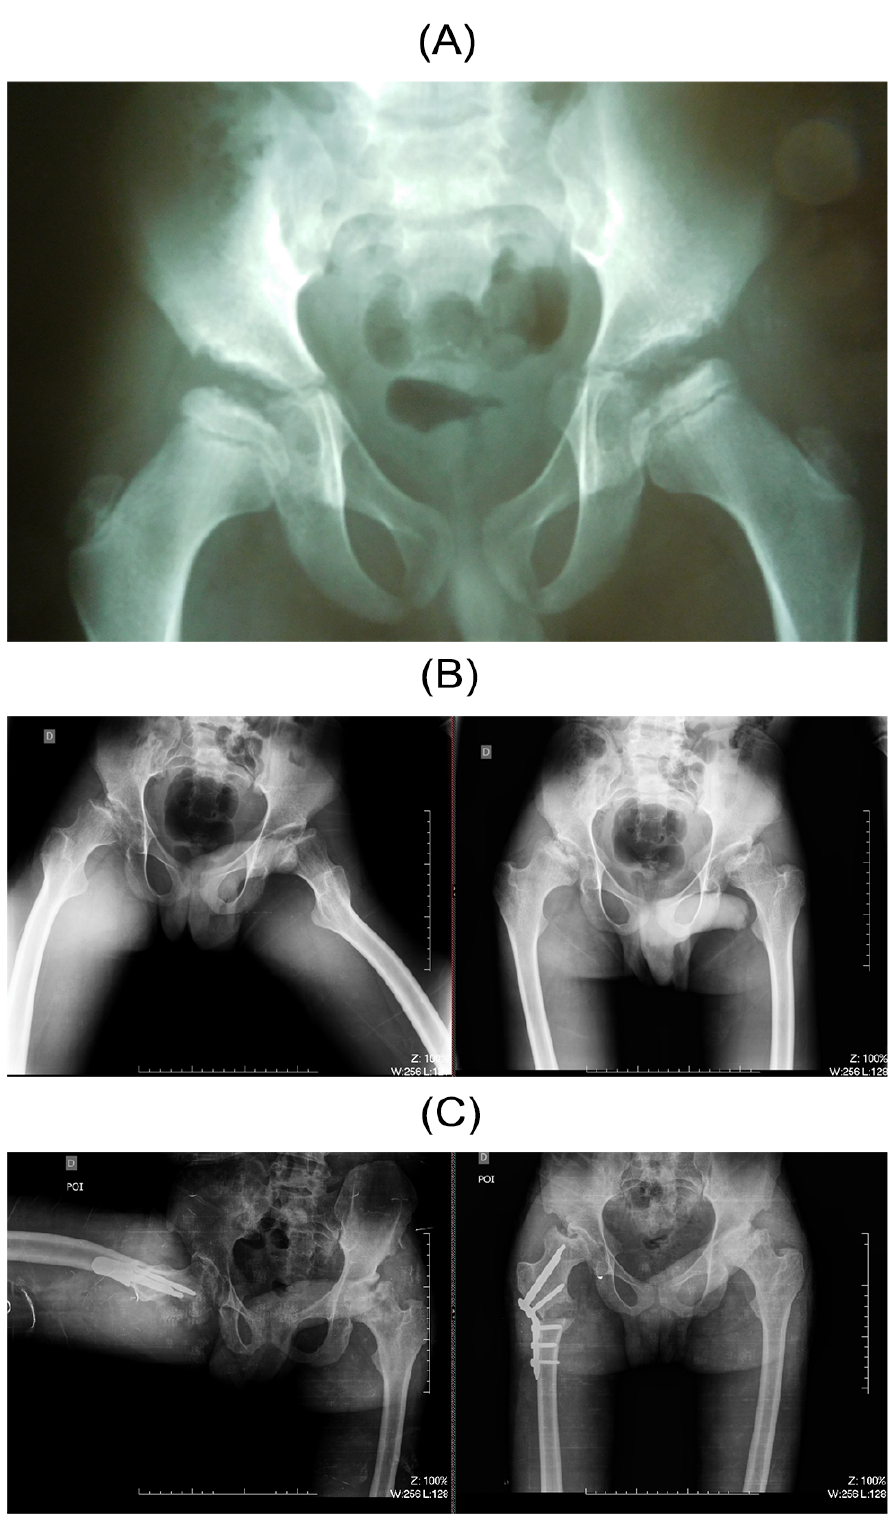
Figure 3. (A) Radiography of hip from a male 9-year-old MPS IVA patient (#patient 10) with acetabular dysplasia, lateral displacement (subluxation) of the femoral head associated with flattening and fragmentation, resembling femoral head avascular necrosis or Perthes disease); (B) Hip radiography of the same patient at the age of 17 years showing acetabular dysplasia, lateral displacement (subluxation) of the femoral head associated with flattening and fragmentation – resembling femoral head avascular necrosis or Perthes disease) and (C) Post-operative (right valgus osteotomy) hip radiography of the same